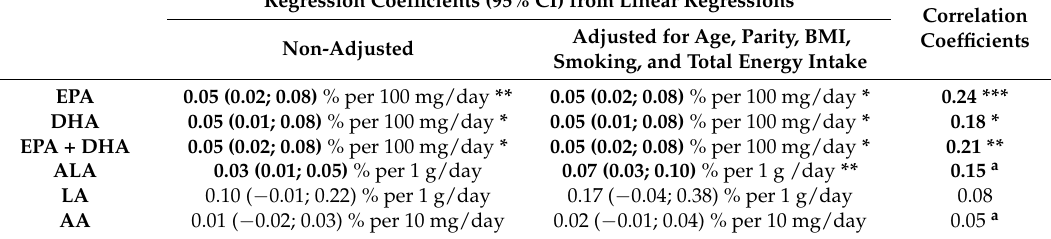
Table 2. Difference in biomarker concentration (%TPFA) per increase in daily intake and correlations between biomarker concentration and intake from Spearman statistics unless indicated otherwise (n = 255).